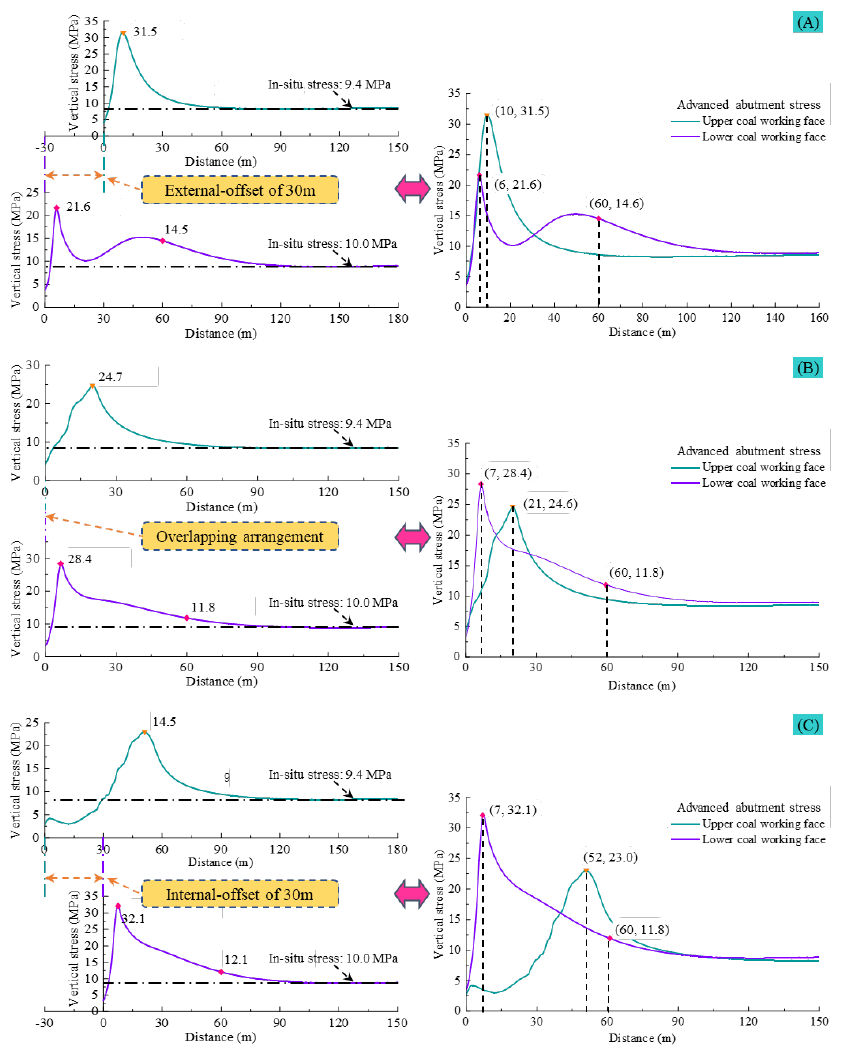
Figure 10. Abutment stress field distribution in the lower coal seam with different offset distances. ( A ) External-offset of 30 m. ( B ) Overlapping arrangement. ( C ) Internal-offset of 30 m.